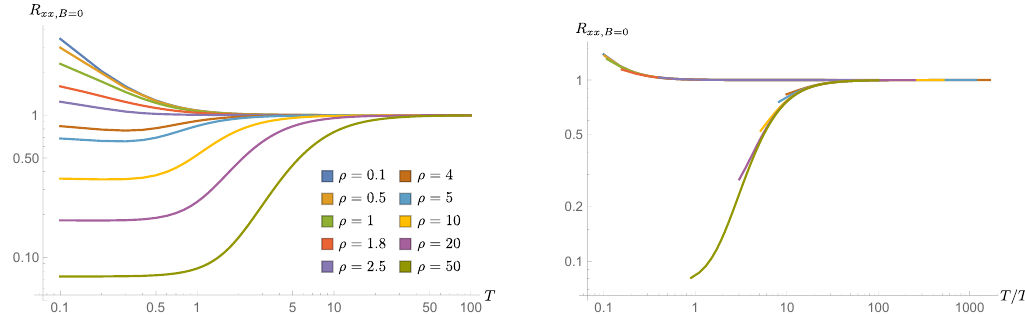
Figure 7 . Temperature dependence of the resistivity for di(cid:11)erent charge densities at zero magnetic (cid:12)eld. Left: the metal-insulator transition by dialing the charge density (cid:26) . Right: scaling of resis- tivity with scaled temperature. R xx ( T ) dependence for di(cid:11)erent (cid:26) of the left plot can be made to overlap by scaling them along the T axis with the scaling parameter T 0 . Near the transition point (cid:26) c (cid:25) 2 : 6, the scaling parameter T 0 (cid:25) 0 : 36 j (cid:26) (cid:0) (cid:26) c j 1 = 2 . We have (cid:12)xed K = (cid:0) 1 = 6 and (cid:11) =